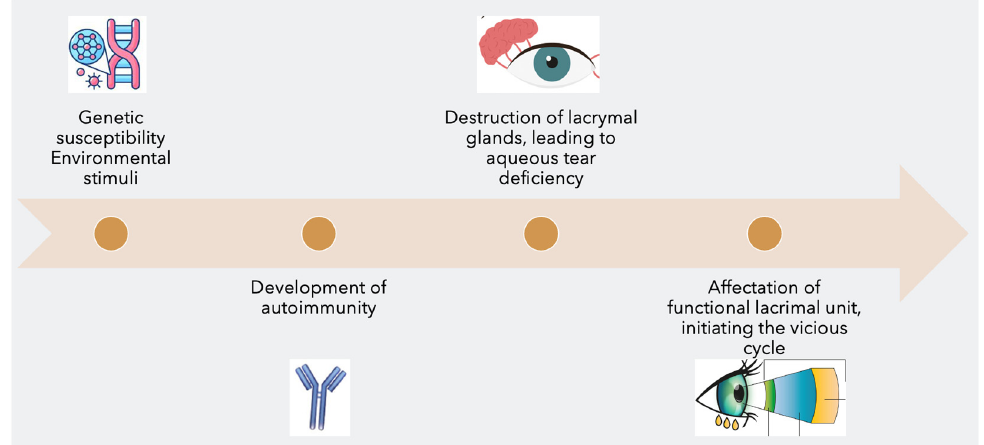
Figure 1. The 4 steps in the pathogenesis of Sjögren’s syndrome dry eye Each of the steps is further detailed in this section.